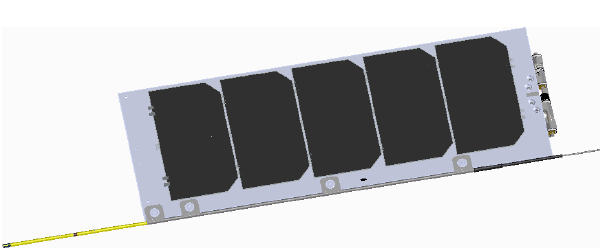
Figure 4. 40mm long probe sticking out of a 40mm long boom (both in yellow) at the extremity of the solar panel. Both the probe and the boom are 2mm outer diameter gold-coated Ti cylinders.